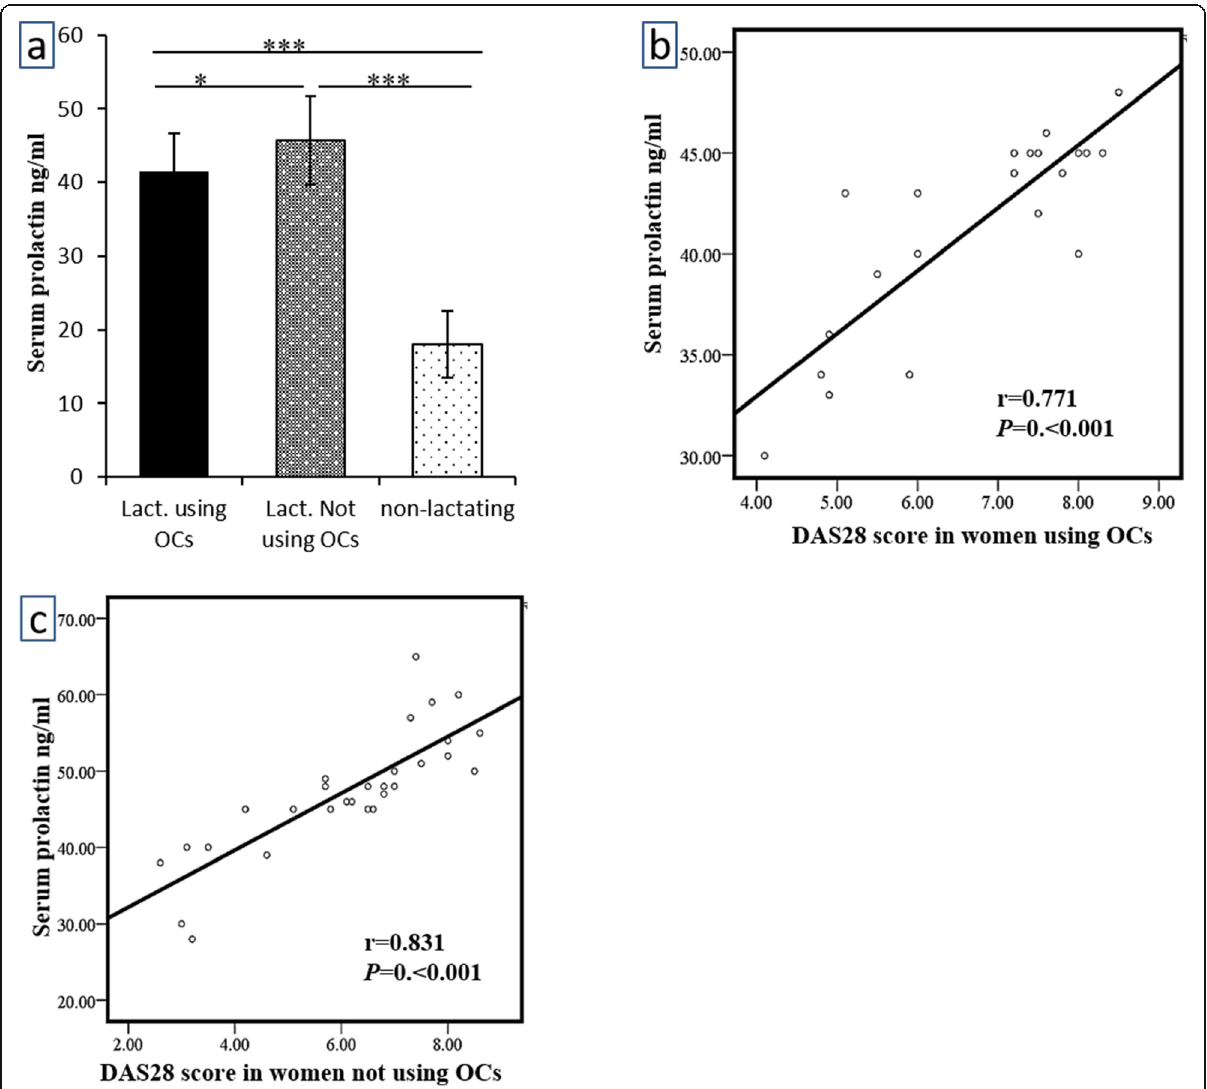
Fig. 5 Effect of oral contraceptives on serum prolactin and its correlation with disease activity. a Serum prolactin level. b Correlation between serum prolactin and DAS28 in lactating women using oral contraceptives. c Correlation between serum prolactin and DAS28 in lactating women not using oral contraceptives. Pearson ’ s correlation was used for calculation of the correlation r = correlation coefficient, * significant difference at p < 0.05, ** high significant difference at p < 0.01, and *** very high significant difference at p <